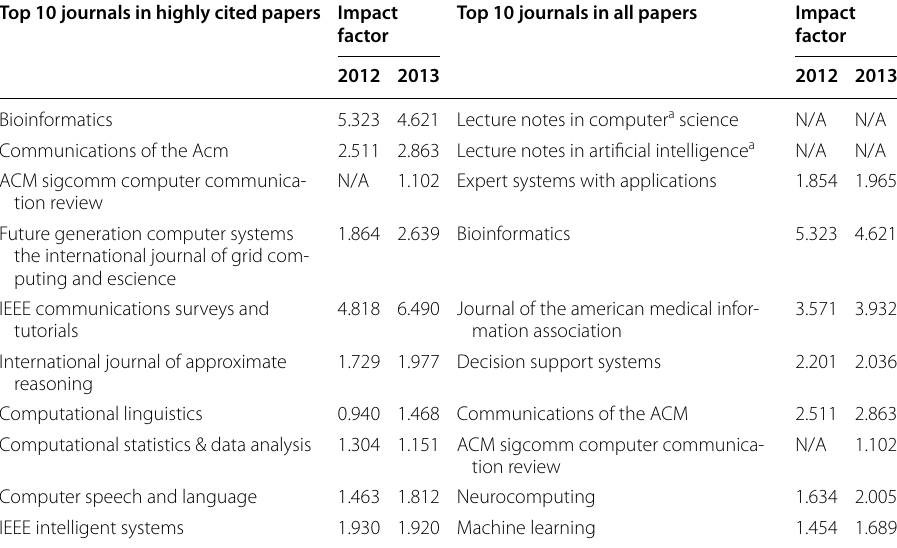
Table 7 The Result of ANOVA test for the effect of the number of publications in all and highly cited source titles